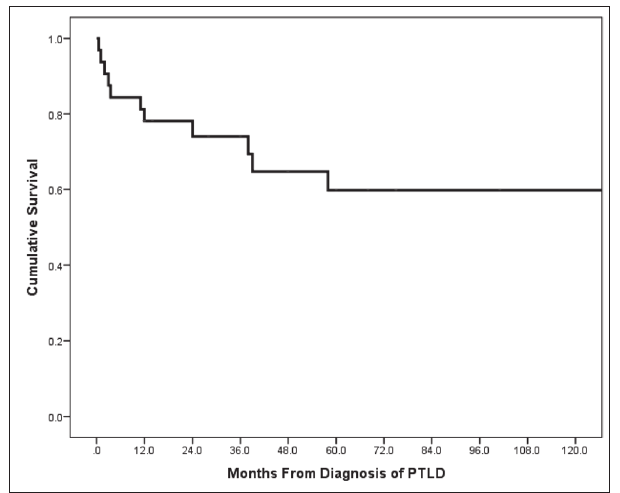
Figure 3) Kaplan-Meier curve showing cumulative survival in 32 patients at one, three and five years after the diagnosis of post-transplant lymphopro- liferative disorder (PTLD)